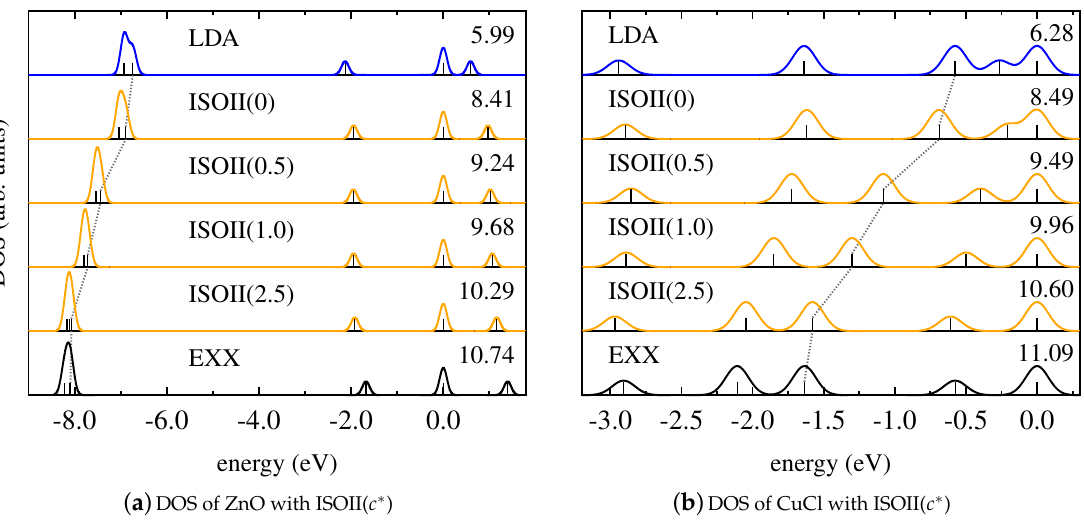
Figure 5. Kohn–Sham DOS obtained with LDA (blue), pure EXX (black), and ISOII in dependence on c ∗ (orange) for ( a ) ZnO and ( b ) CuCl.